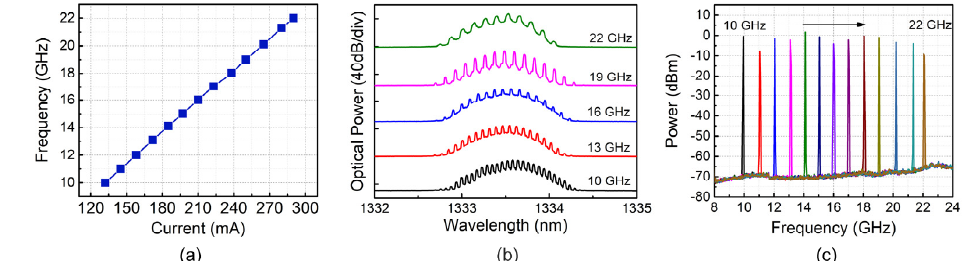
Figure 6. ( a ) The relationship between the center frequency of the YIG filter and the driving current; ( b ) overlapped optical spectrum of the PM − YIG − RMLL; ( c ) overlapped RF spectrum of the PM − YIG − RMLL.